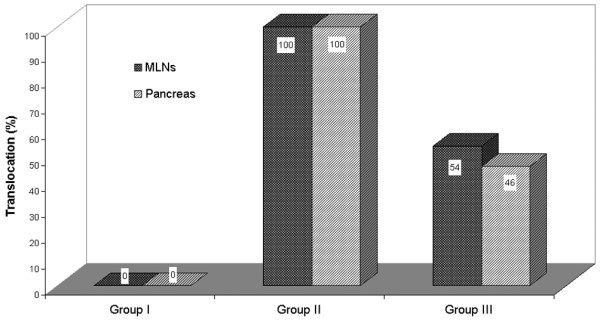
Incidences of bacterial translocation to mesenteric lymph nodes (MLNs) and pancreas. Group I, sham operated group; group II, positive control group; group III, activated protein C treated group.